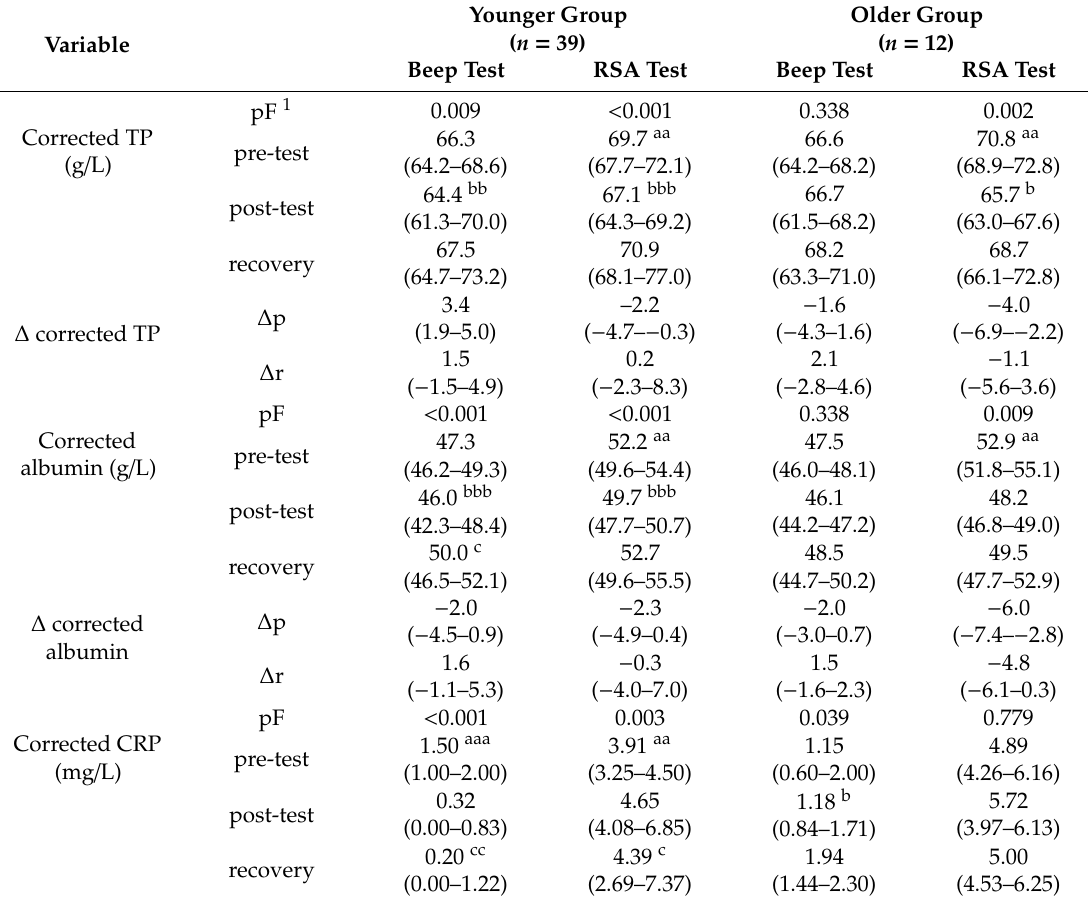
Table 3. Selected biochemical variables of studied participants’ blood